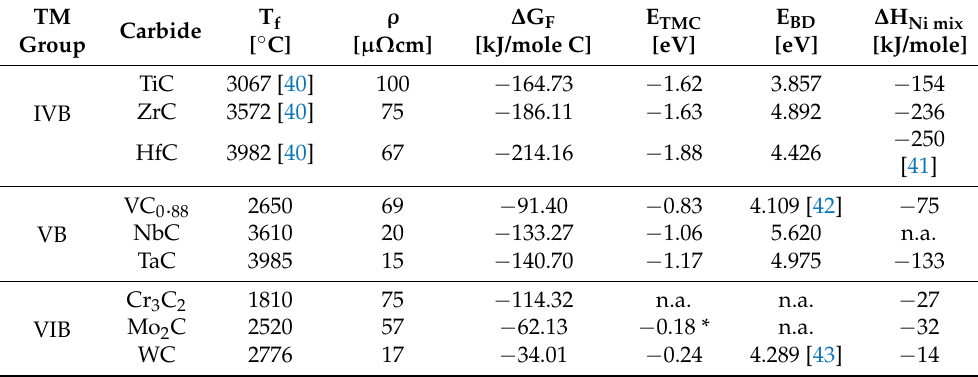
Table 7. TMCs of the IVB–VIB groups: melting point T f [35], electrical resistivity ρ [35], standard free